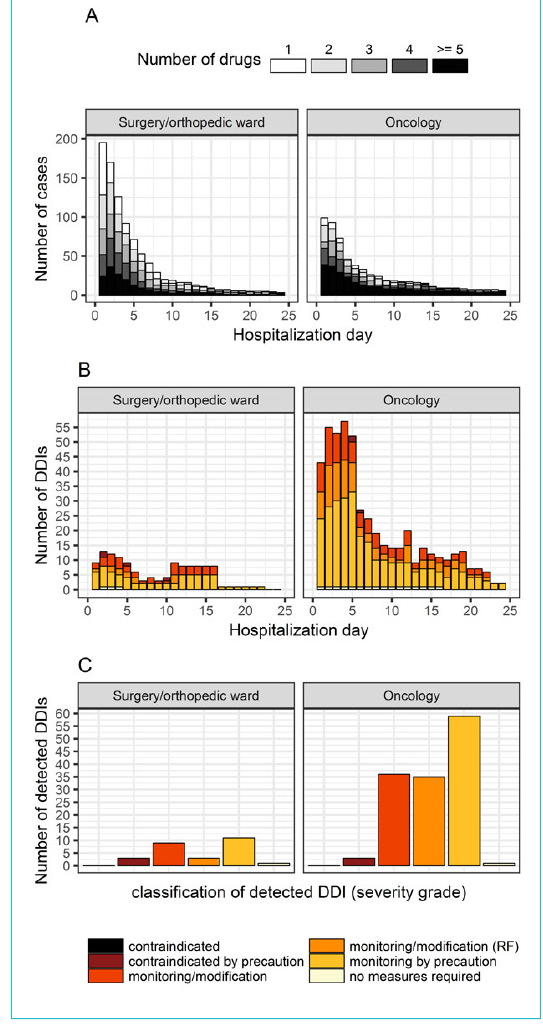
Figure 2: A: Daily drug exposure and B: Detected drug-drug inter- actions (DDIs) over the hospitalisation period. C: Distribution and classification of detected drug-drug interactions (DDIs) according to assigned severity grades. RF = therapy monitoring/modification in case of risk